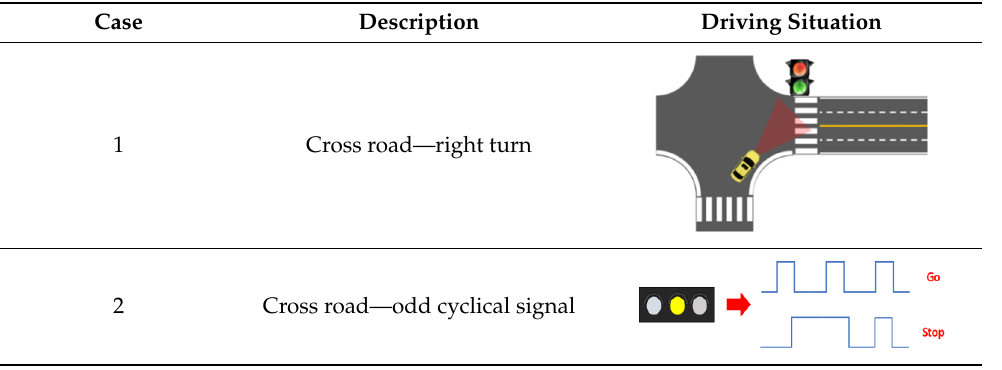
Table 16. V2X scenario examples.